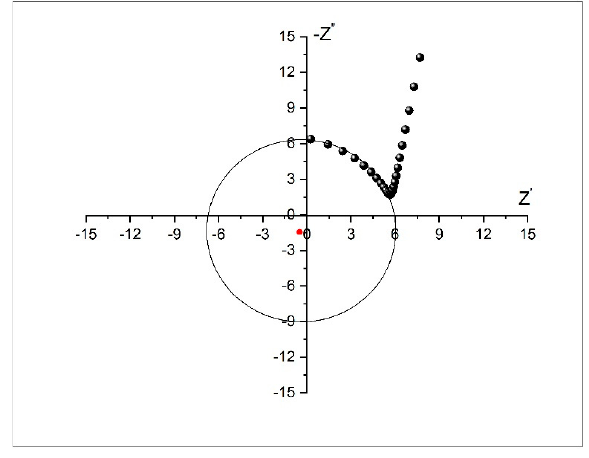
Figure 8. Cole–Cole (Nyquist) plot of the dealloyed glassy alloy ribbon sample. Three points are noted here. Appearance of negative resistance has been observed